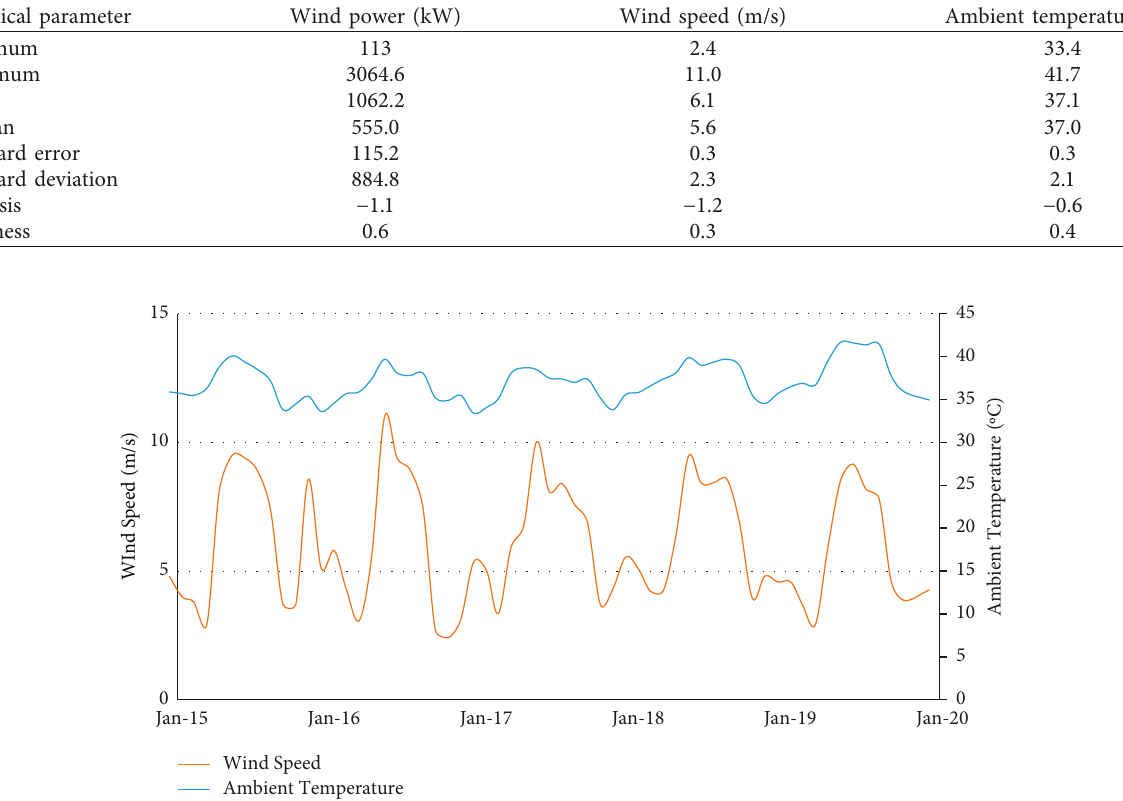
Table 1: Statistical parameters of data set.